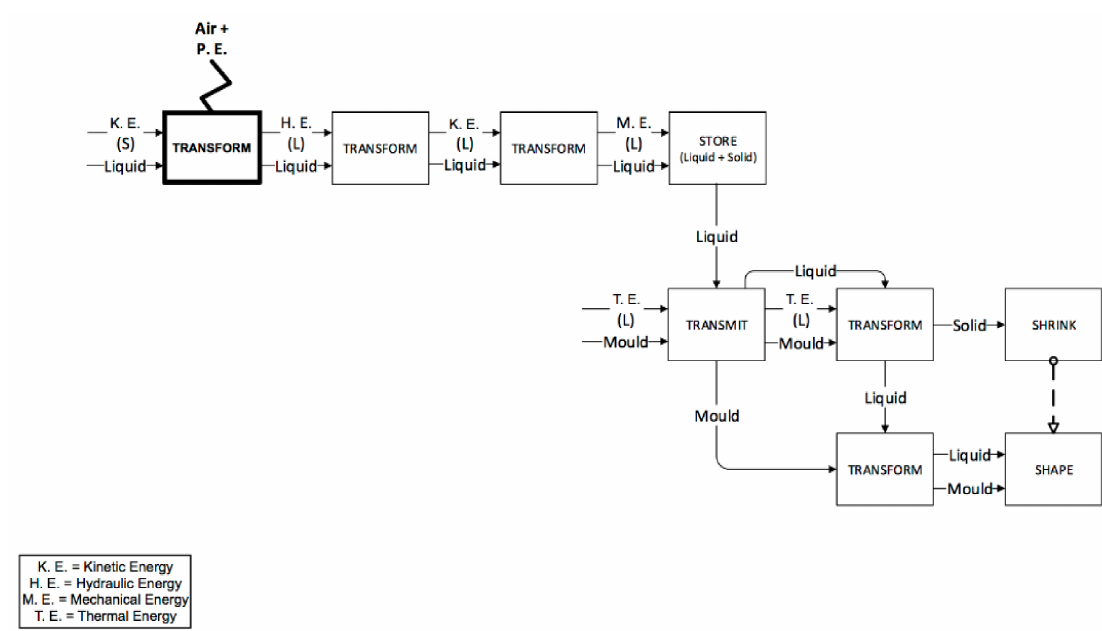
Figure 11. Packing phase for the IM